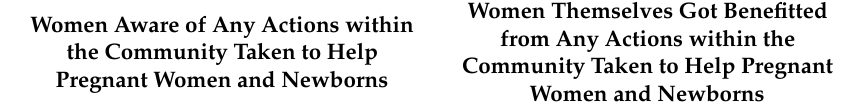
Table 2. Women’s awareness regarding any actions within the community *, and got themselves benefitted from any actions within the community (Kasba = 452 and Sarail =